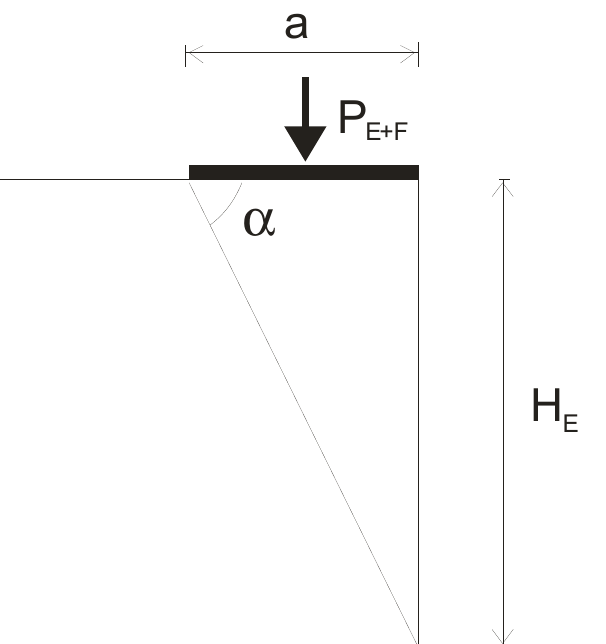
Figure 10. Triangular contact area between the sand and the side wall in the failure